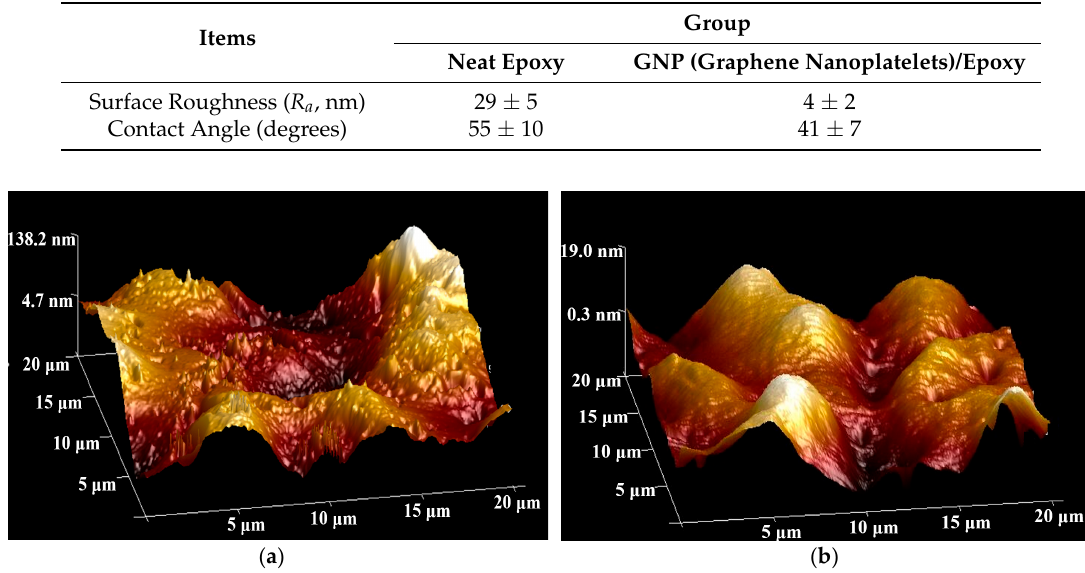
Figure 13. AFM images of ( a ) the neat epoxy, ( b ) group 1.0%G-Epoxy.